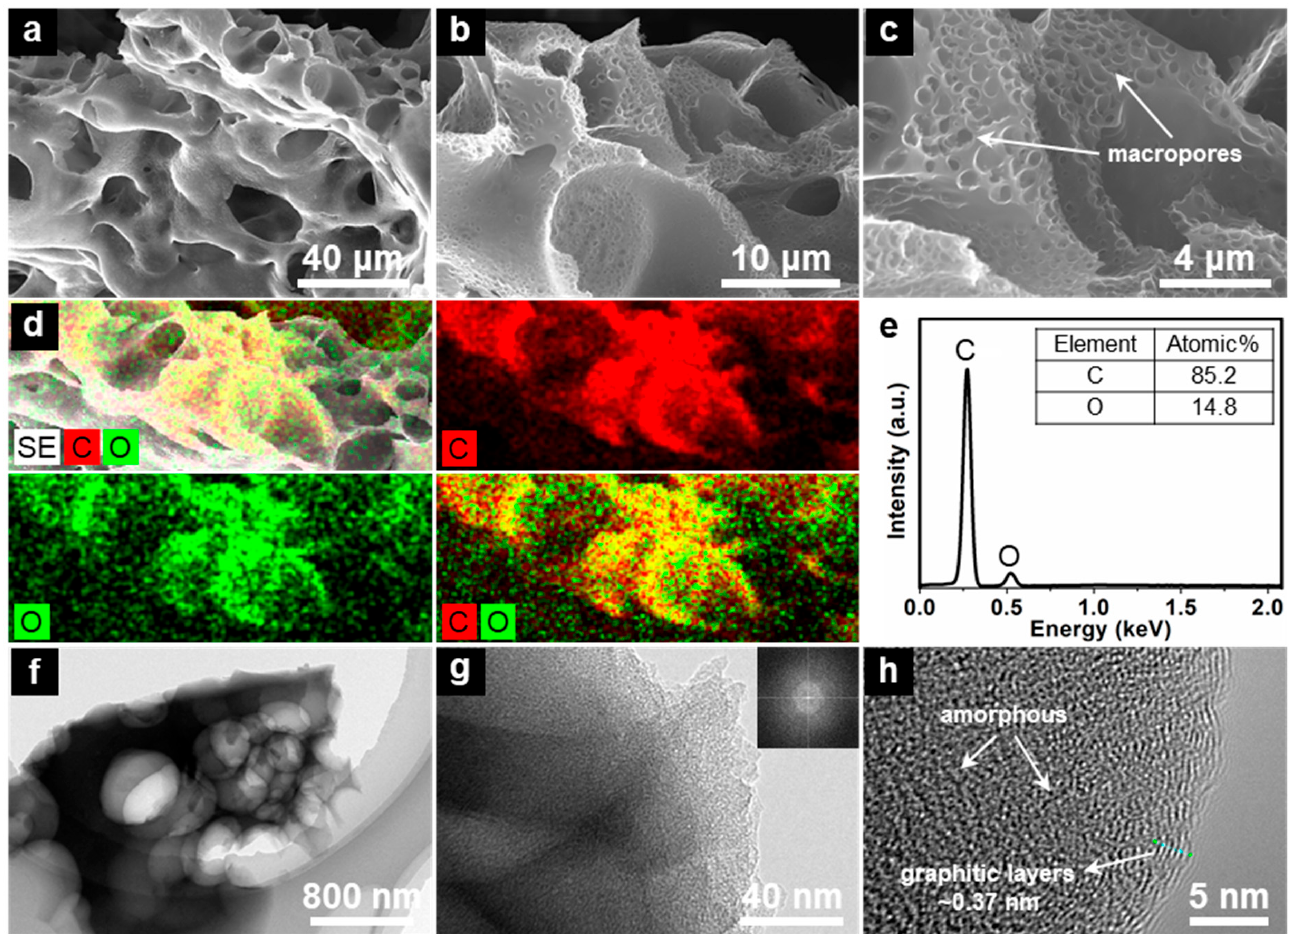
Figure 4. Representative morphological characterizations of Alg-C material. ( a – c ) SEM images under different magnifications. ( d ) SEM-EDX micrograph and corresponding elemental mapping images of carbon and oxygen and ( e ) EDX spectrum. ( f – h ) TEM images recorded at different magnifications. Inset: FFT of the image of ( g ).